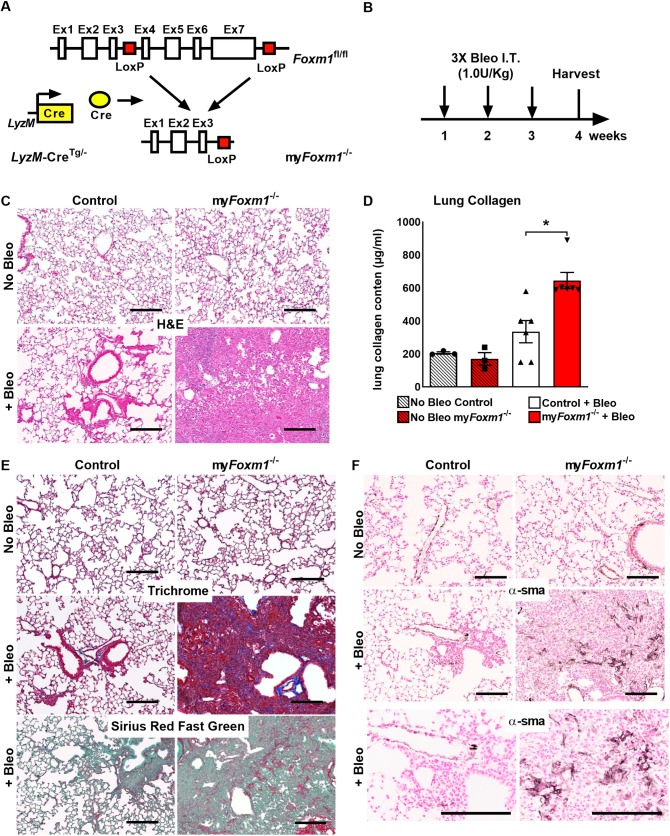
Conditional deletion of Foxm1 in myeloid cells exacerbates bleomycin-induced pulmonary fibrosis in mice.(A) Schematic diagram shows breeding strategy for the deletion of Foxm1 from myeloid cells (myFoxm1-/-). (B) Schematic representation for bleomycin-induced pulmonary fibrosis in mice. 8–10 weeks old myFoxm1-/- and control mice were treated with bleomycin intratracheally (1U/kg; once a week for three weeks). Mice were sacrificed, and lungs were collected one week after the final bleomycin treatment. (C) Deletion of Foxm1 from myeloid cells does not affect lung architecture in uninjured mice as shown by H&E staining (top panels). Increased pulmonary fibrosis was detected in bleomycin-treated myFoxm1-/- mice compared to control bleomycin-treated mice (bottom panels). Scale bar = 200μm. (D) Increased lung collagen content, as quantified by Sircol assay, was detected in bleomycin-treated myFoxm1-/- mice compared to control (n = 6 mice per group). (E) Increased lung collagen deposition in bleomycin-treated myFoxm1-/- mice was shown using Masson’s trichrome and Sirius red fast green staining. Scale bar = 200μm. (F) Deletion of Foxm1 from myeloid cells increased number of αSMA+ myofibroblasts in bleomycin-treated myFoxm1-/- mice. No changes in the number of αSMA+ lung myofibroblasts were found in uninjured myFoxm1-/- mice compared to control lungs (n = 5 mice per group). Scale bar = 200μm. * = P < 0.05.